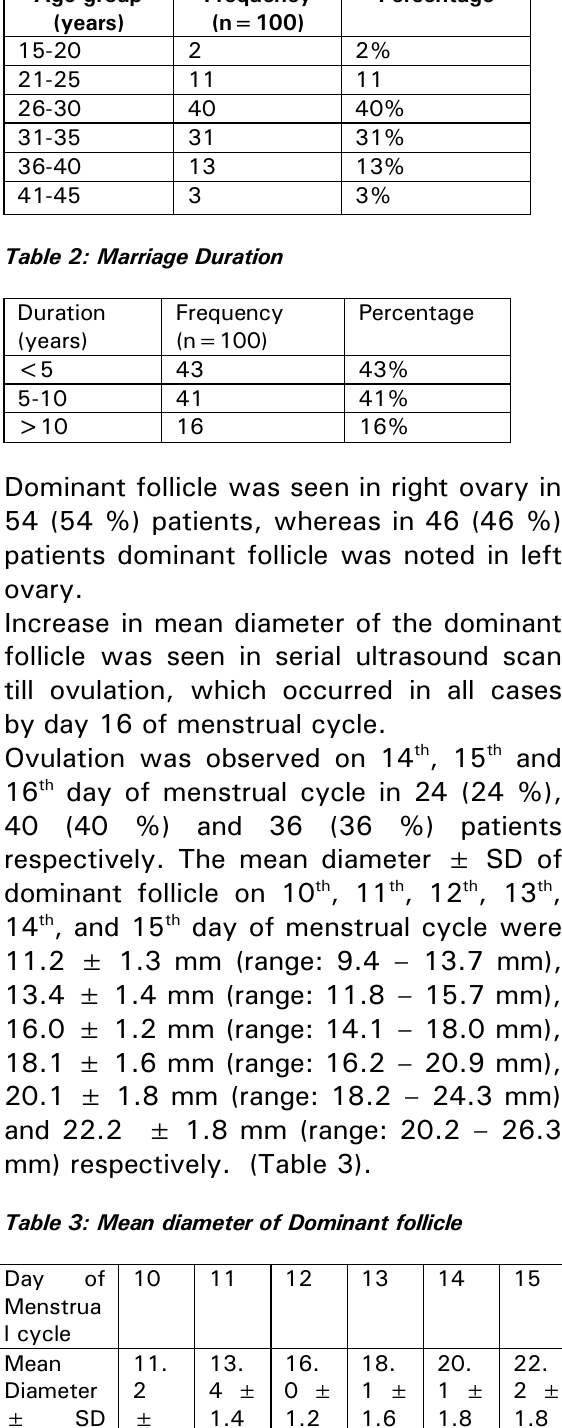
Figure 2: Involution of dominant follicle with increase internal echoes on transvaginal sonography performed on day 15 of menstrual